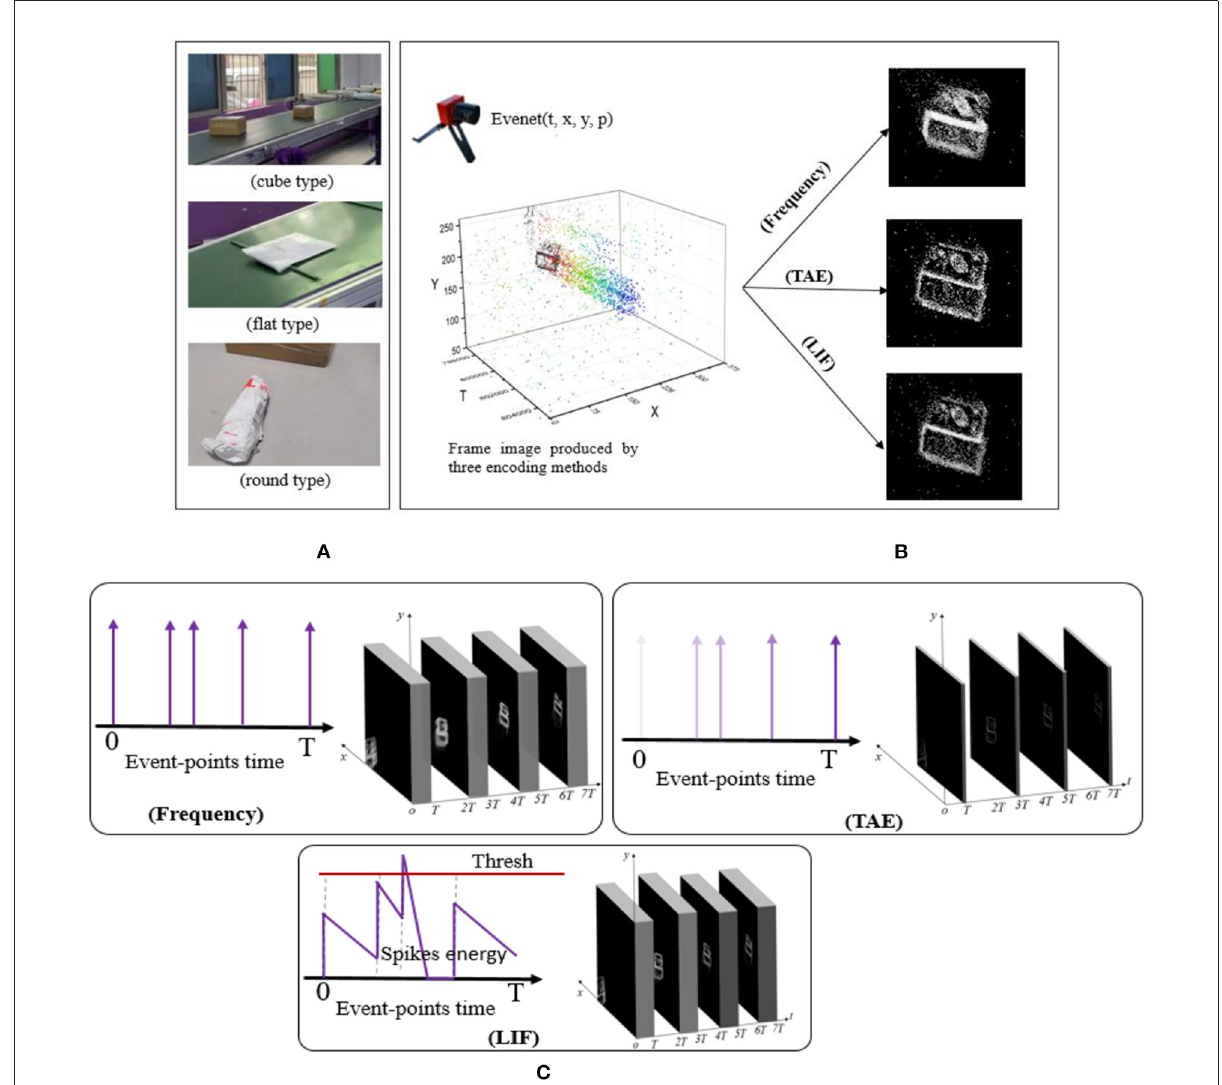
FIGURE2 (A) The different delivery packages, namely cube, round, and flat types. (B) The frame images encoded by the Frequency, TAE, and LIF methods. (C) The link and outputs among the three encoding methods in a time-interval. The TAE algorithm can strengthen the display of the nearest event-points and weaken the event-points in the time-interval’s initial moment, which can promote the packages’ actual appearance instantly.